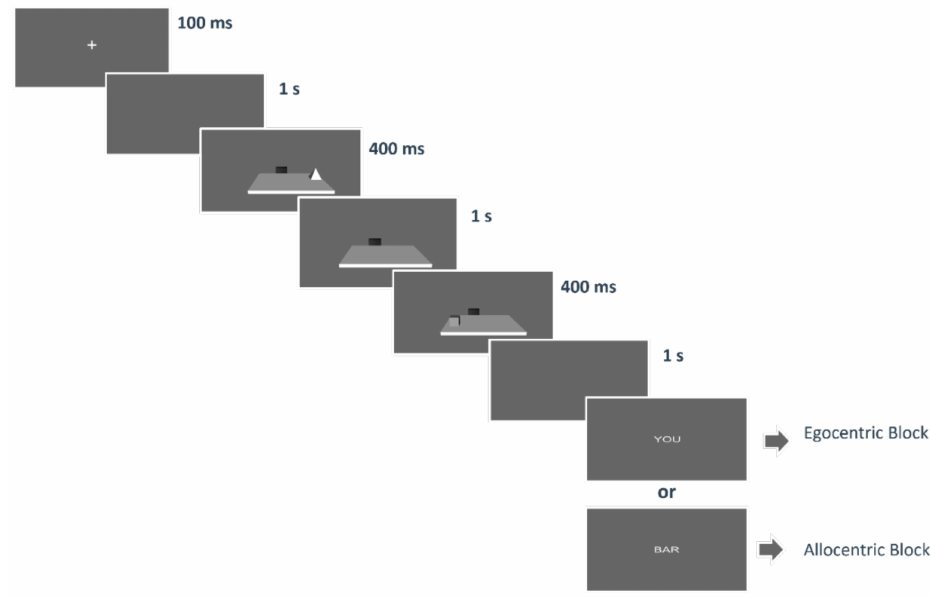
Figure 3. The figure shows a schematic representation of the sequence of events of a